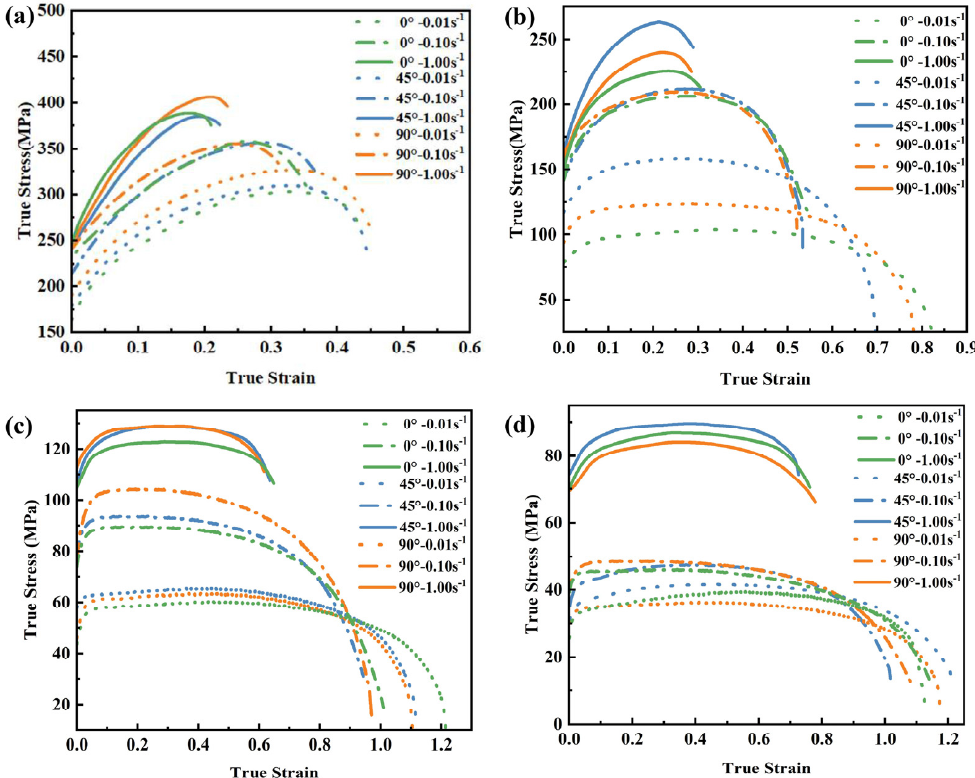
Figure 3. The true stress–true plastic strain curves for Al5083 at different temperatures: ( a ) 200 ◦ C; ( b ) 300 ◦ C; ( c ) 400 ◦ C; ( d ) 450 ◦ C.